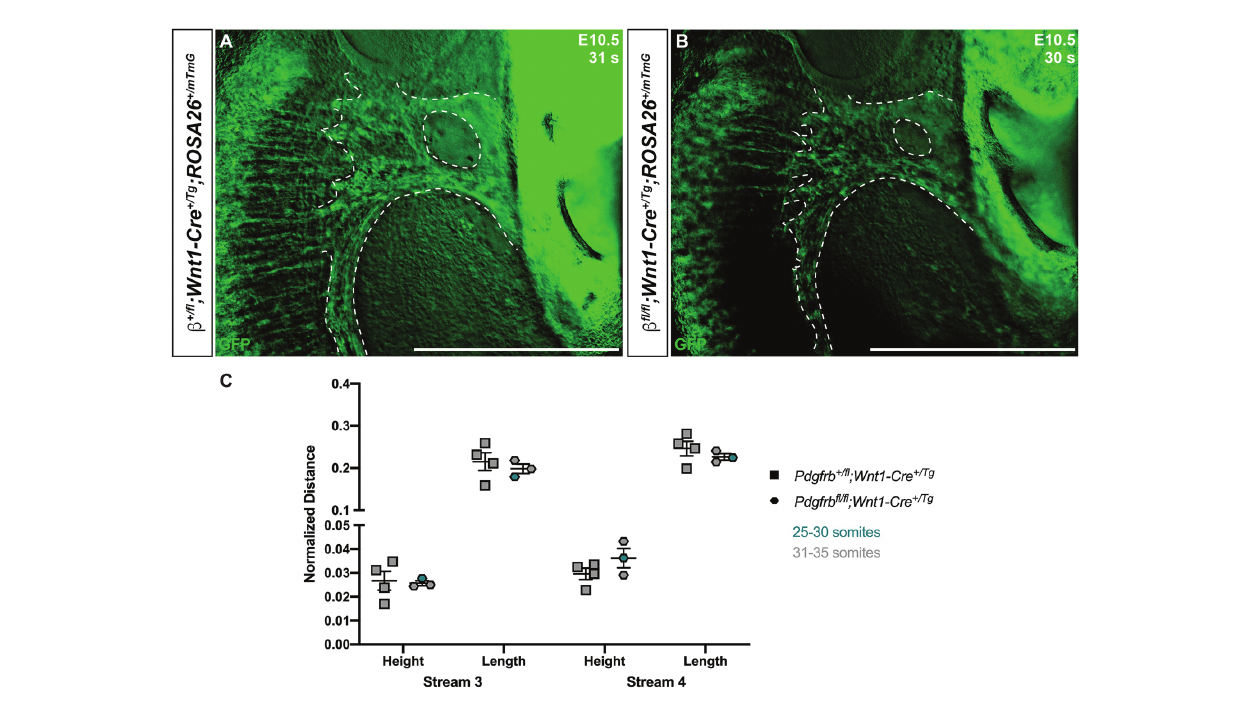
FIGURE 5 | Ablation of Pdgfrb in the NCC lineage does not affect cNCC streams entering PA3 and PA4 at E10.5. (A,B) Zoomed-in images of GFP expression in cNCC streams (outlined by dotted lines) entering PA3 and PA4. (C) Scatter dot plot depicting the normalized anterior-posterior heights and dorsal-ventral lengths of cNCC streams entering PA3 and PA4 across two genotypes at E10.5. Data are presented as mean ± SEM. Colors correspond to number of somite pairs in assayed